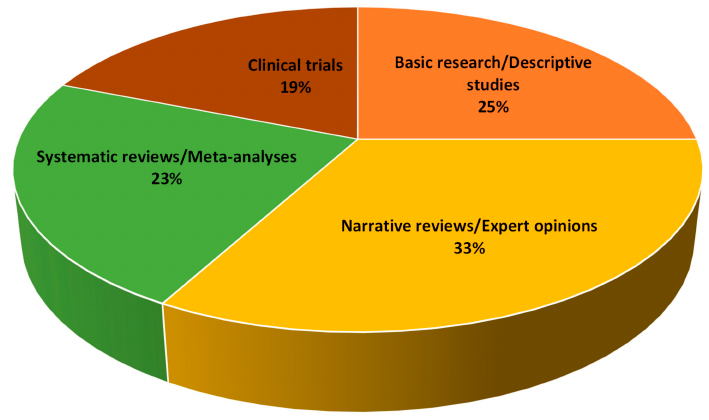
Figure 1. Methodological designs of the top 100 most cited papers in melatonin research.